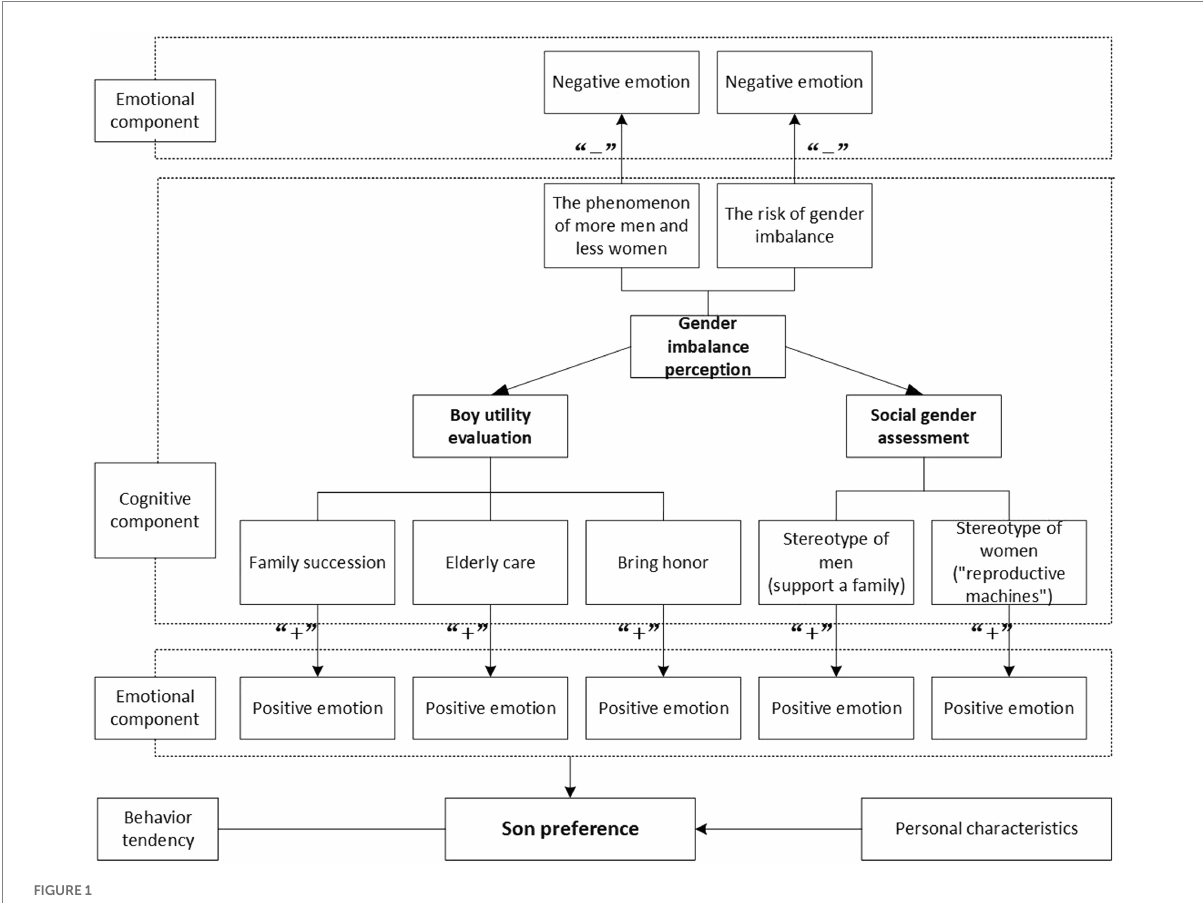
FIGURE 1 Framework of influencing factors of son